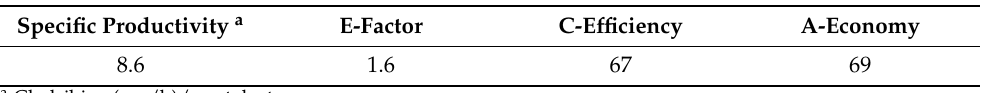
Table 2. Scale-up bioprocess for cladribine biosynthesis using a batch bioreactor. Environmental factors were calculated as previously reported [38,63] .